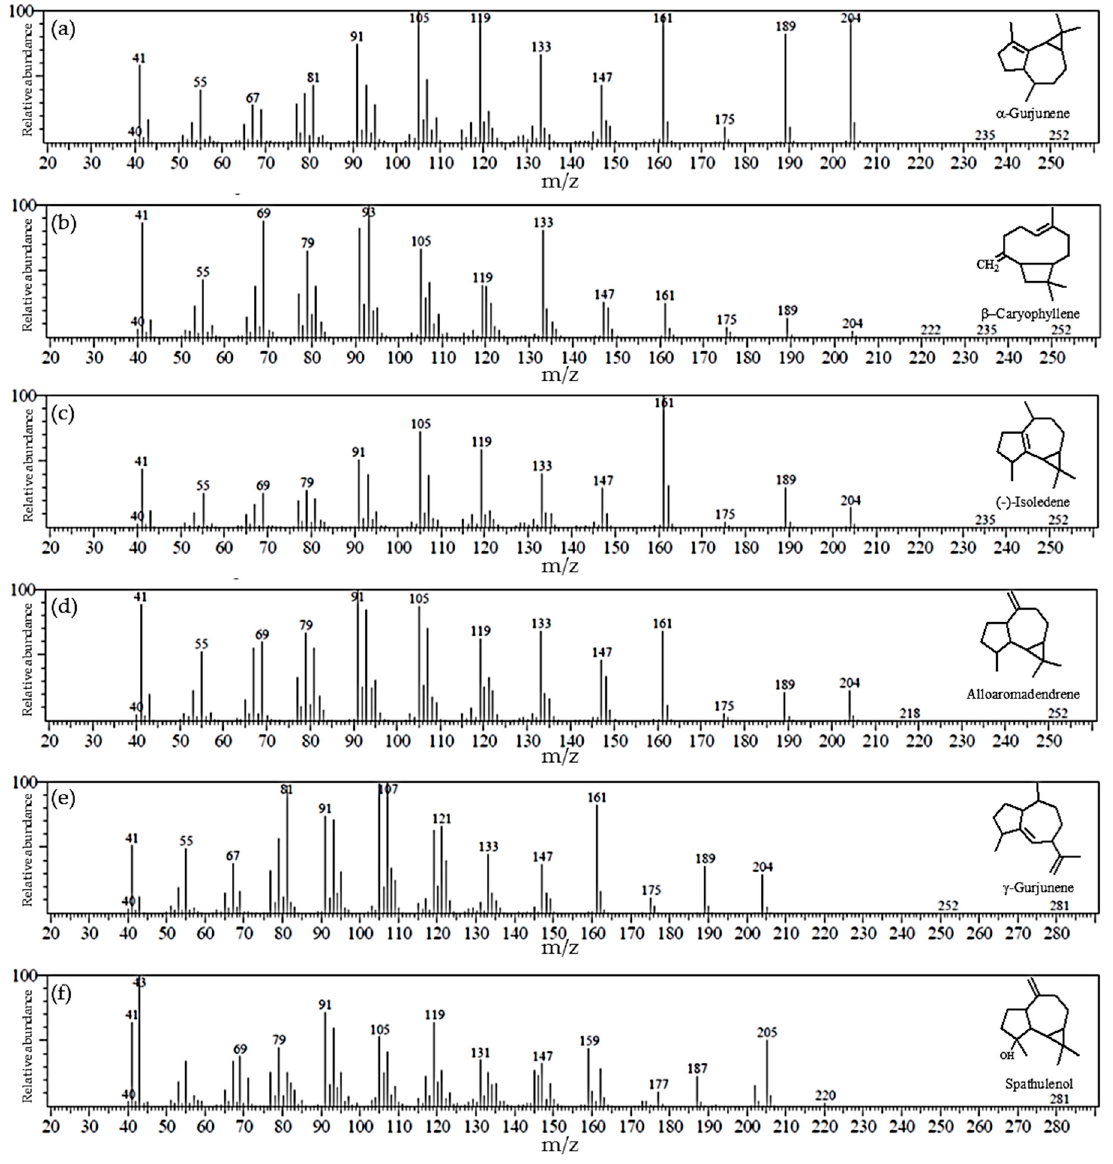
Figure 1. Gas chromatography-mass spectrometry (GC-MS) spectra of the major sesquiterpenes in oleo-resin. ( a ) α -Gurjunene; ( b ) ( − )-isoledene; ( c ) alloaromadendrene; ( d ) β -caryophyllene; ( e ) γ -gurjunene; and ( f ) spathulenol.